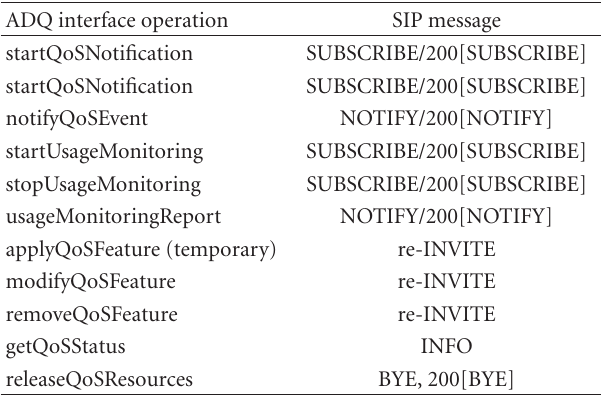
Table 3: Mapping overview of ADQ interfaces onto